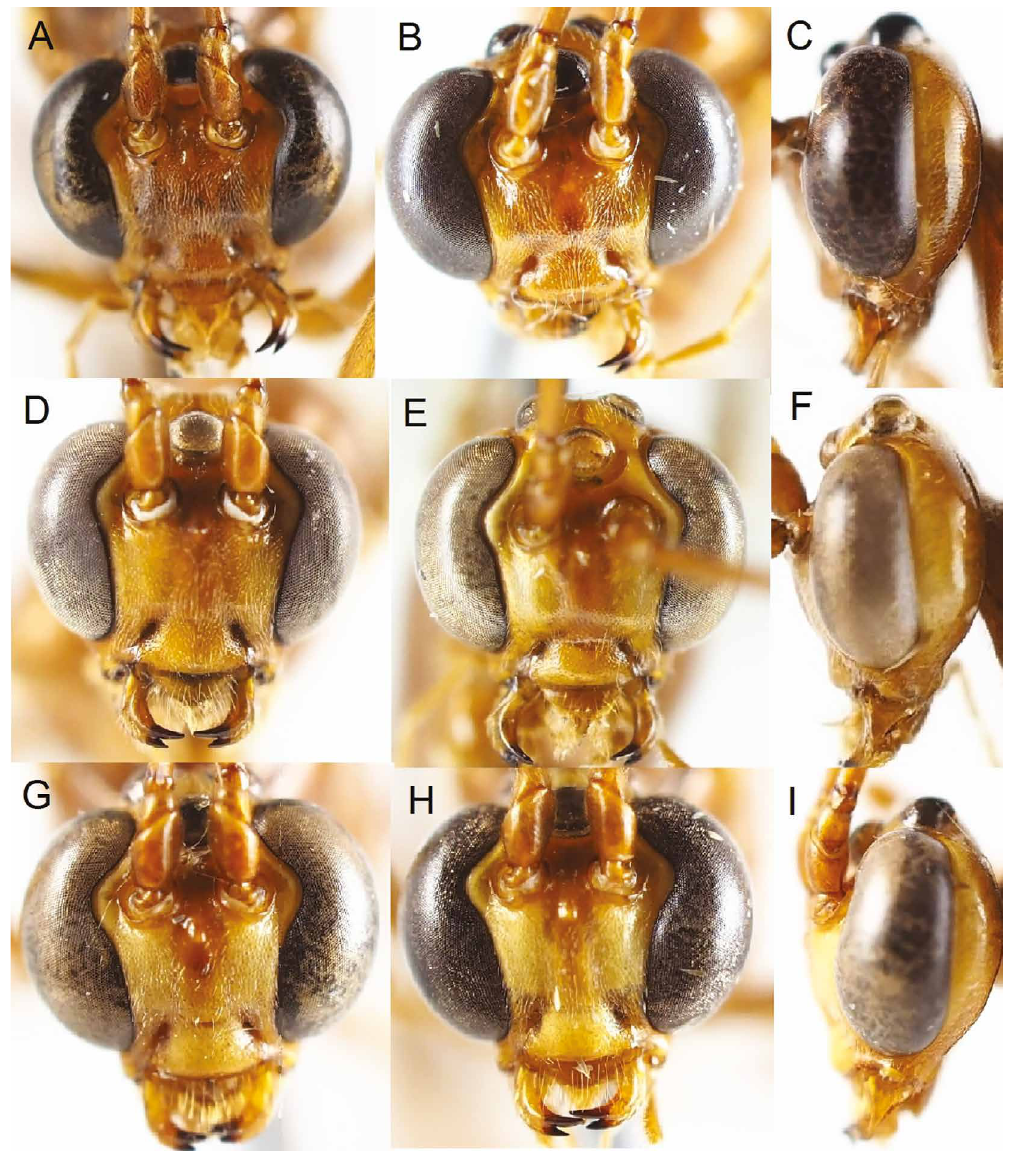
Fig. 9. Head, anterior and lateral view. A–C . Enicospilus intermedius sp. nov., paratypes, ♀♀ (NHRS-HEVA000008171, NHRS-HEVA000008166). D–F . E. myricae Broad & Shaw, 2016, ♀♀. G–I . E. adustus (Haller, 1885),